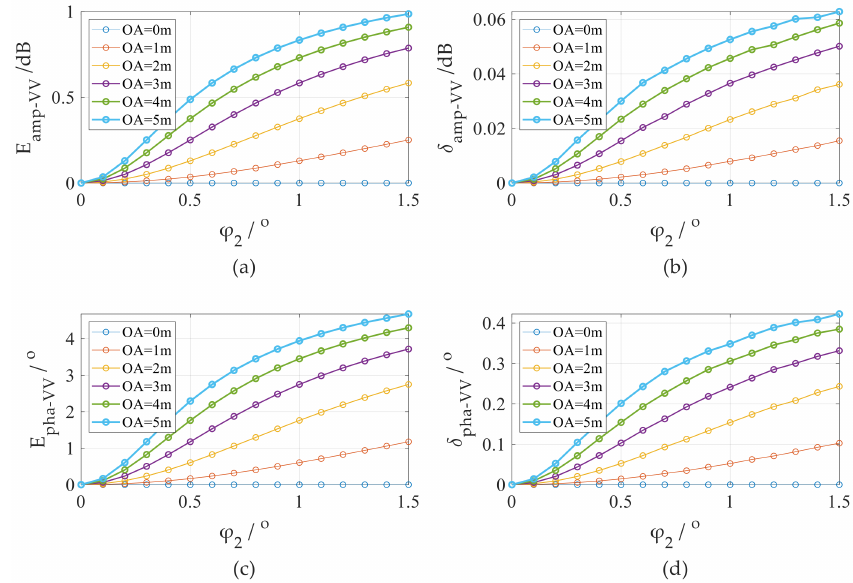
Figure 4. The effects of beam alignment errors on the calibration precision of co-polarization channel (VV). ( a ) Expectation of amplitude errors; ( b ) standard deviation of amplitude errors; ( c ) expectation of phase errors; ( d ) standard deviation of phase errors.